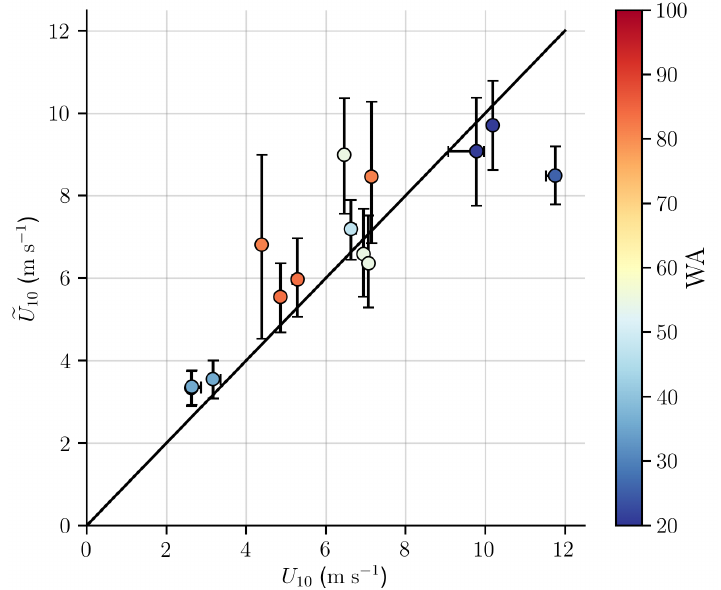
Figure 7. Comparison between ( U 10 ) wind speed obtained from ERA5 and ( (cid:101) U 10 ) associated wind speed derived from the SAR images with the BPM model using Equation (8). The observations were grouped into 0.5 m s − 1 bins, where the circles are mean values. Vertical and horizontal bars represent percentiles of 5% and 95%. Colors represent the wave age of observations (see Table